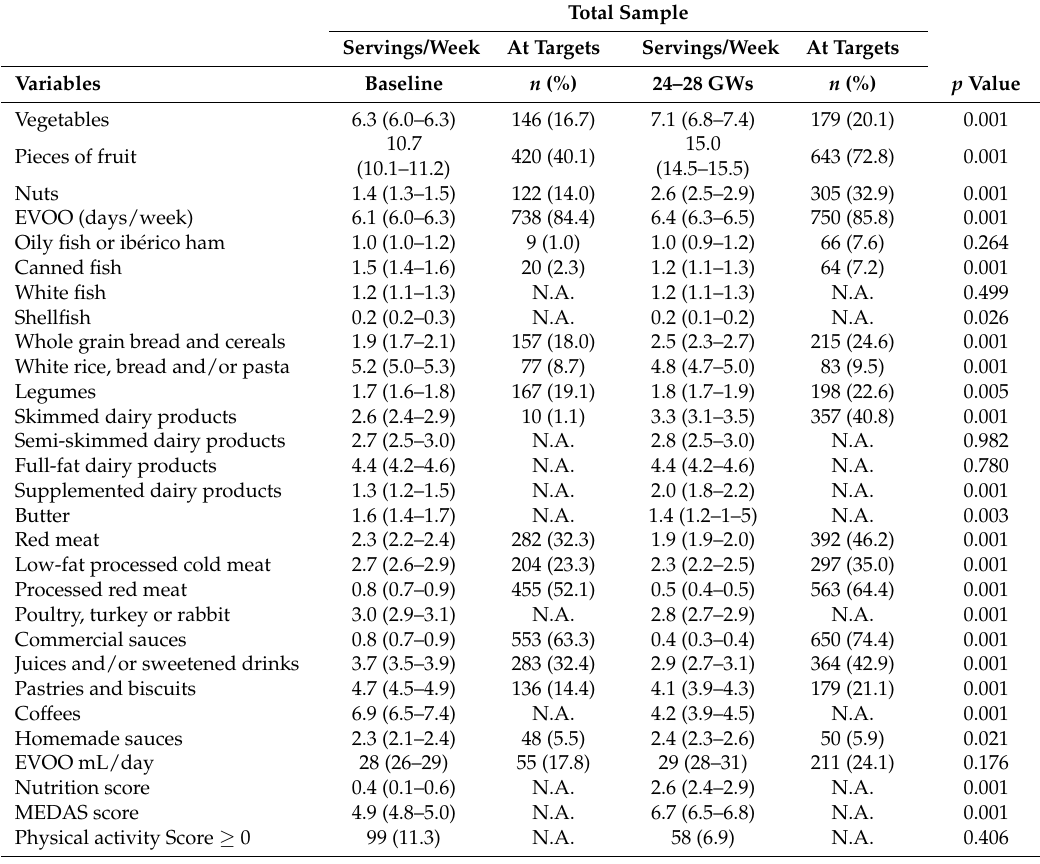
Table 2. Consumption of individual food groups at baseline (12–14 GWs), and at 24–28